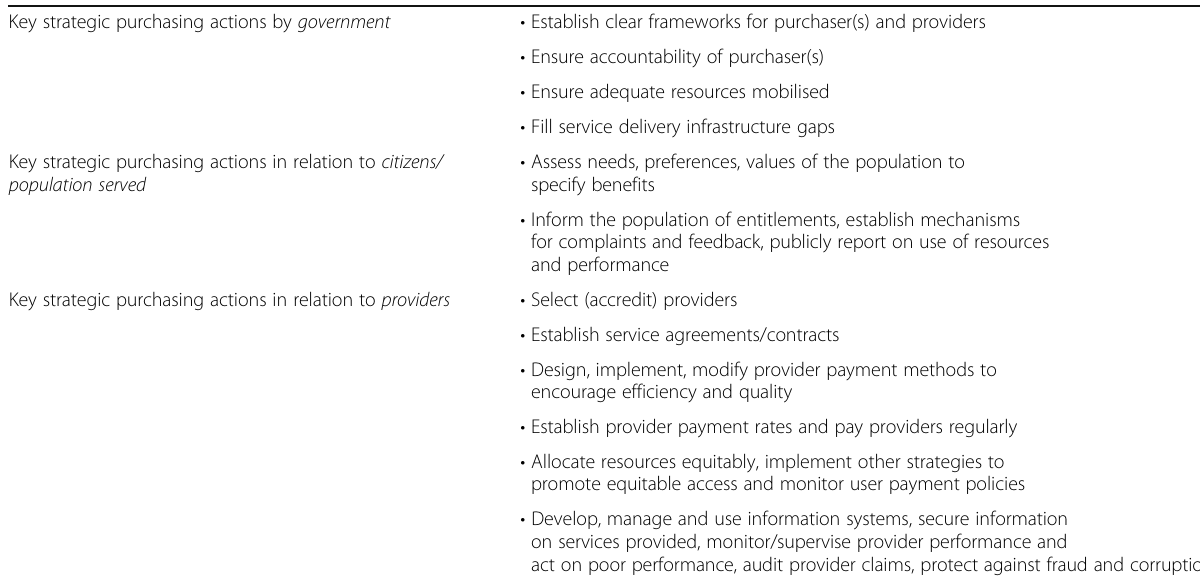
Table 2 Key actions for strategic purchasing in relation to different stakeholders within the health system Key strategic purchasing actions by